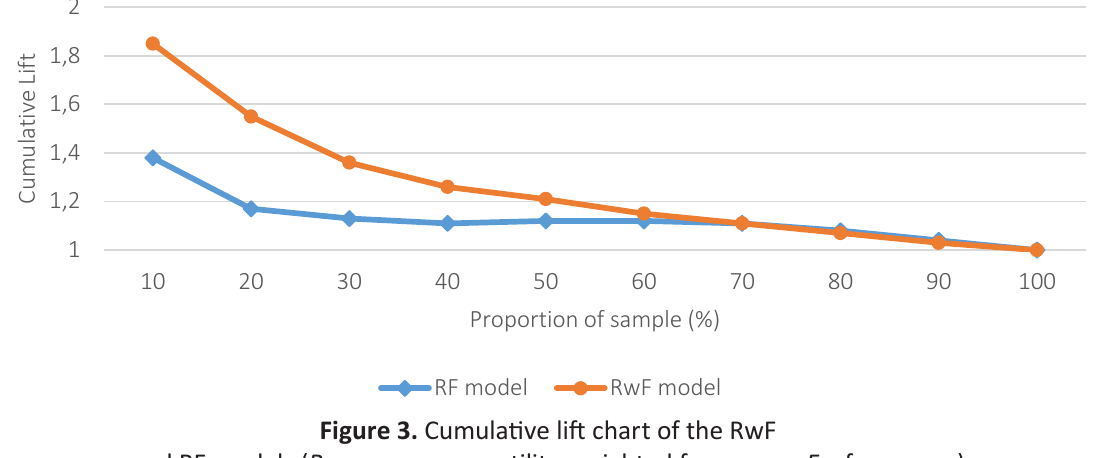
Figure 3. Cumulative lift chart of the RwF